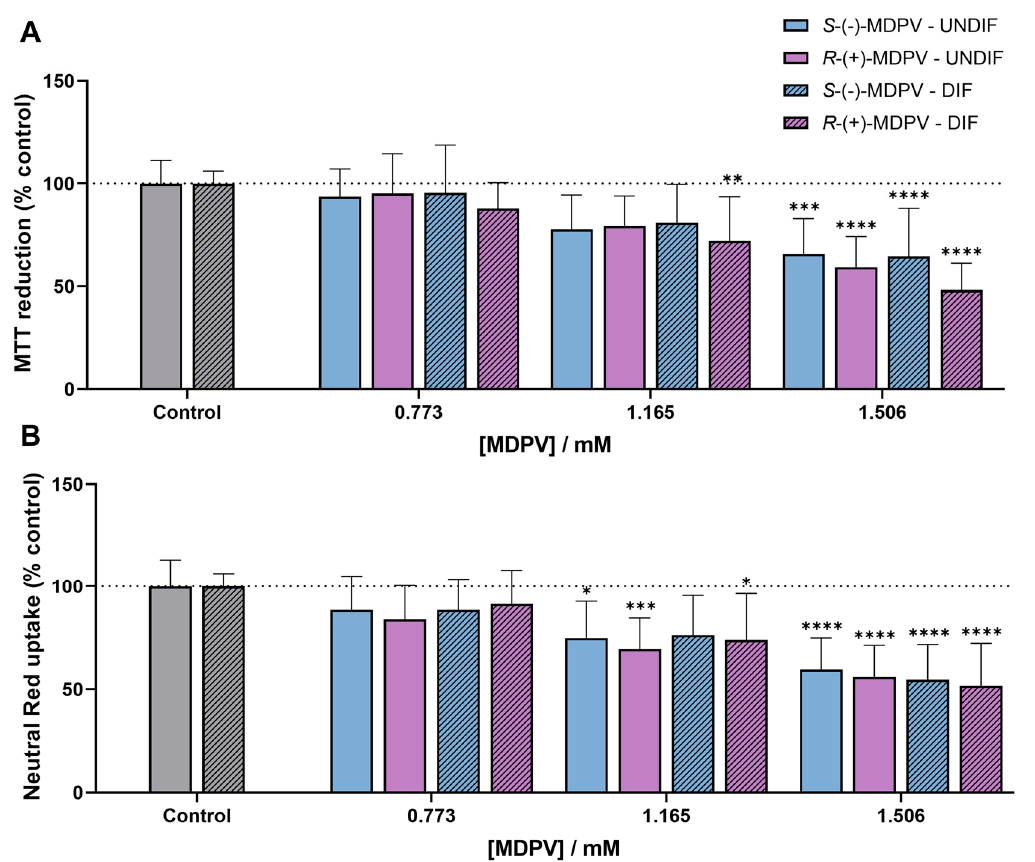
Figure 8. Reduction of MTT ( A ) and NR uptake ( B ) in undifferentiated (UNDIF) and differentiated (DIF) SH-SY5Y cells exposed to the individual enantiomers of MDPV in three concentrations (0.773; 1.165, and 1.506 mM) for 24 h. Results are expressed as mean ± standard deviation (SD) obtained from four independent experiments, run in triplicate. * p < 0.05, ** p < 0.01, *** p < 0.001, **** p < 0.0001 vs. respective control samples (undifferentiated or differentiated cells without treatment).